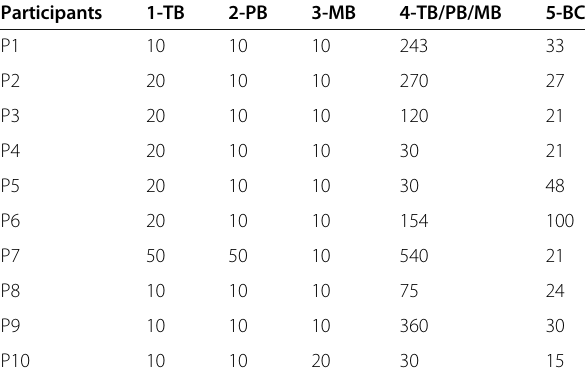
Table 3 Number of training trials in experiment